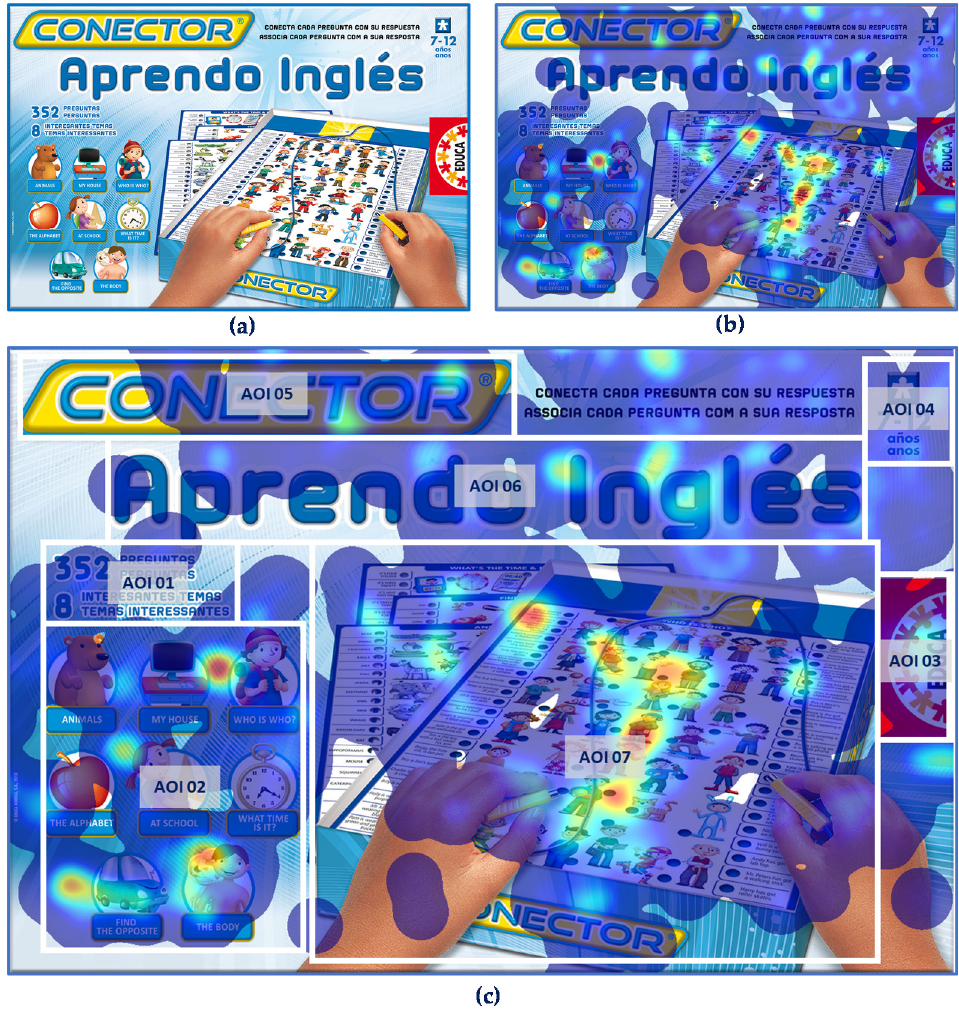
Figure 3. Toy packaging original image ( a ), heat map ( b ) and heat map with AOIs ( c ). Source: Prepared by the authors.